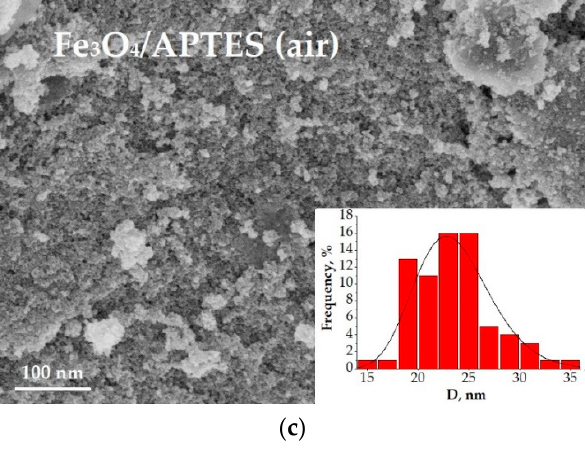
Figure 2. SEM image of ( a ) Fe 3 O 4 , ( b ) Fe 3 O 4 /APTES (Ar), ( c ) Fe 3 O 4 /APTES (air) and their size distribution. FTIR spectra. The FTIR spectra of Fe 3 O 4, Fe 3 O 4 /APTES(Ar) and Fe 3 O 4 /APTES (air) na-